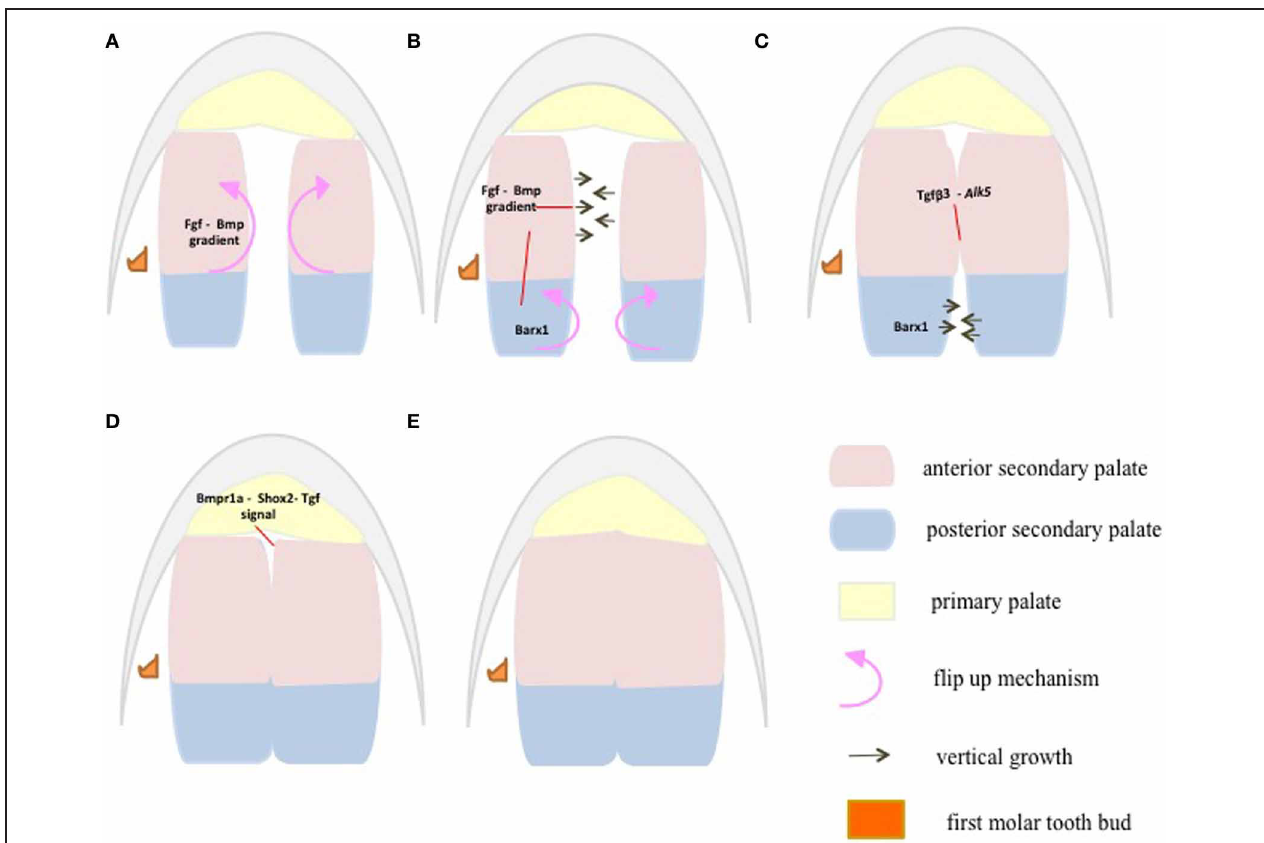
FIGURE 4 | At E13.5, the anterior palatal shelves first flip up to orient vertically when the posterior palatal shelves are still lying horizontal to each other (A) . At E14, the posterior palatal shelves follow the anterior palatal shelves in orienting vertically, whereas the anterior palates begin to grow vertically toward each other to make contact (B) . At E15, the anterior palatal shelves have made contact and fused, whereas the posterior shelves grow vertically (C) . At E15.5, both the anterior and posterior palates have fused (D) . At E16, the fusion between the primary and secondary palate occurs at the future secondary choana (E) . Palatal shelves are divided into anterior (pink) Msx1 and posterior (aqua) Barx1 expression domains (A–E) representing